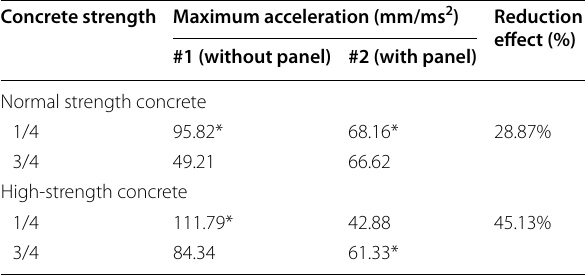
Table 5 Vibration reduction effect of blast‑proof panel in field